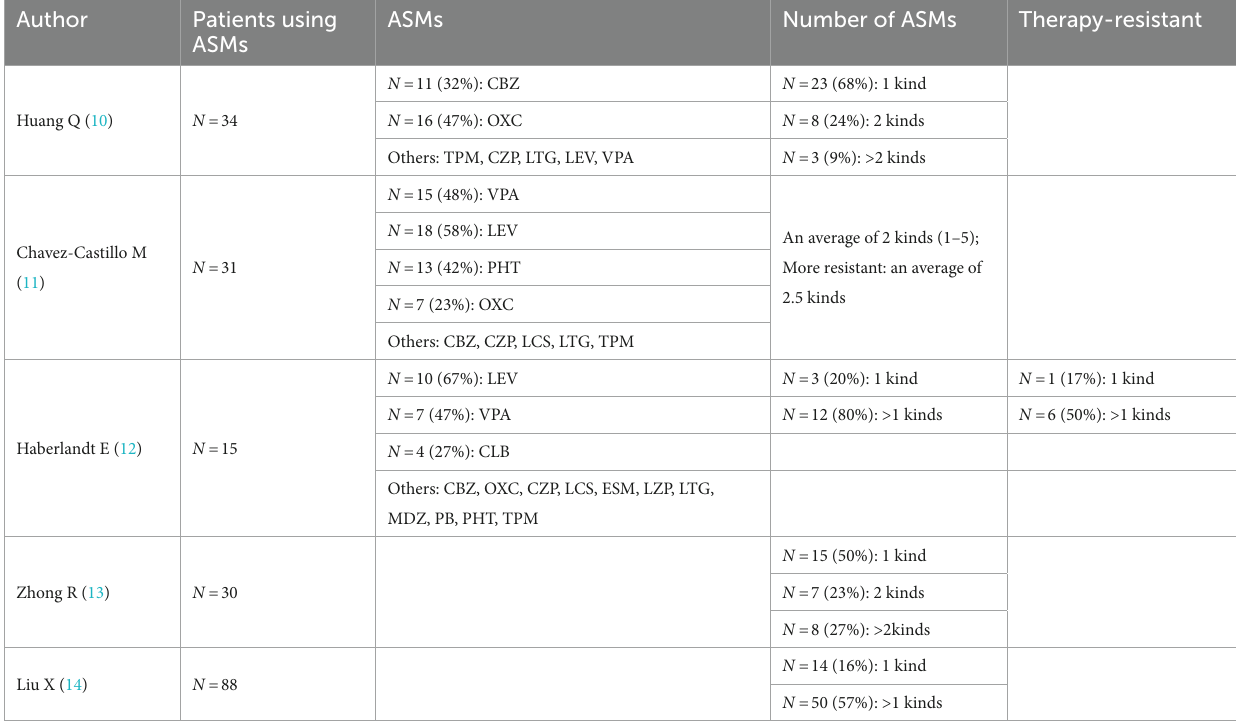
TABLE 2 Number and type of ASMs in anti-NMDAR